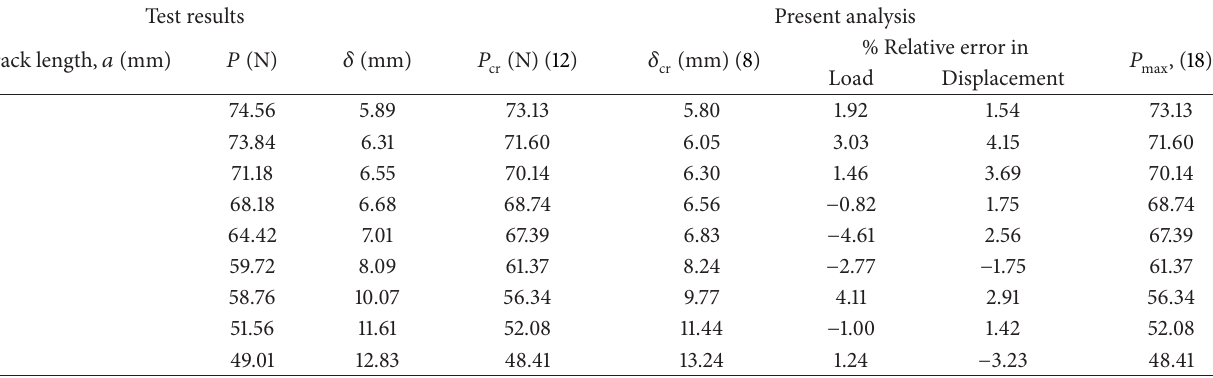
Table 2: Critical load, 𝑃 , and corresponding displacement, 𝛿 cr glass/epoxy composite.